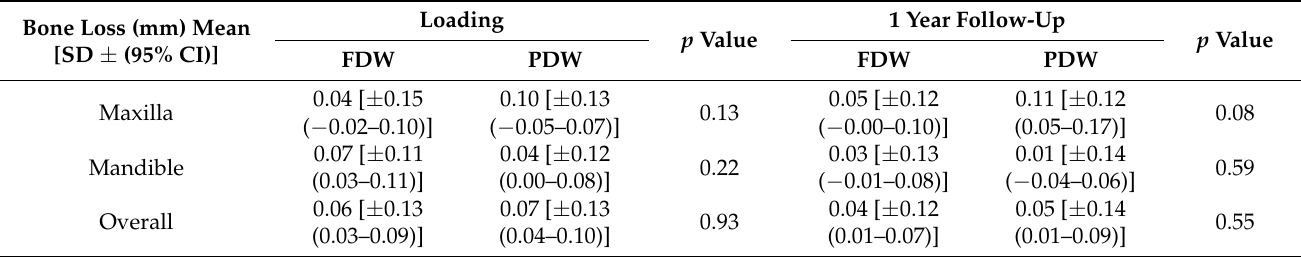
Table 2. Mean bone loss at prosthetic insertion and one-year follow-up.